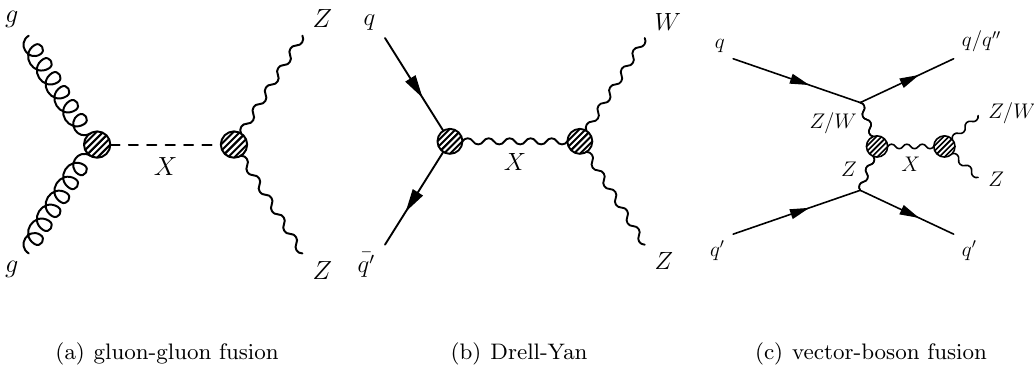
Figure 1 . Representative Feynman diagrams for the production of heavy resonances X with their decays into a pair of vector